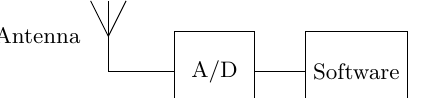
Figure 2: Ideal software-defined radio consisting of an antenna, an analog-to-digital converter and dig- ital signal processing (DSP) on a general purpose computer.